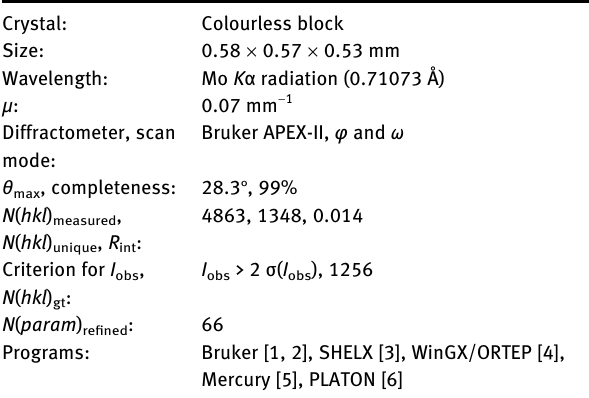
Table  : Data collection and handling. Crystal: